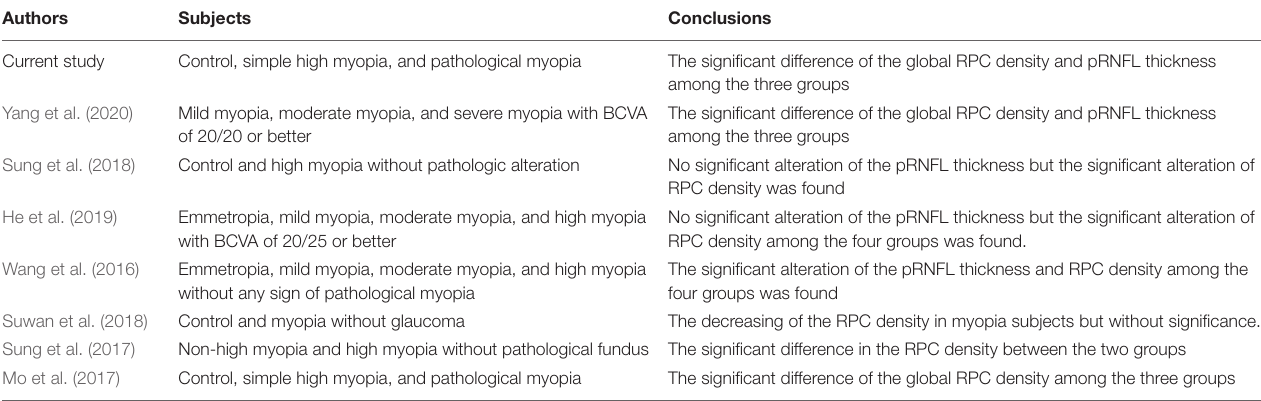
TABLE 8 | Summary of previous article on peripapillary alteration in